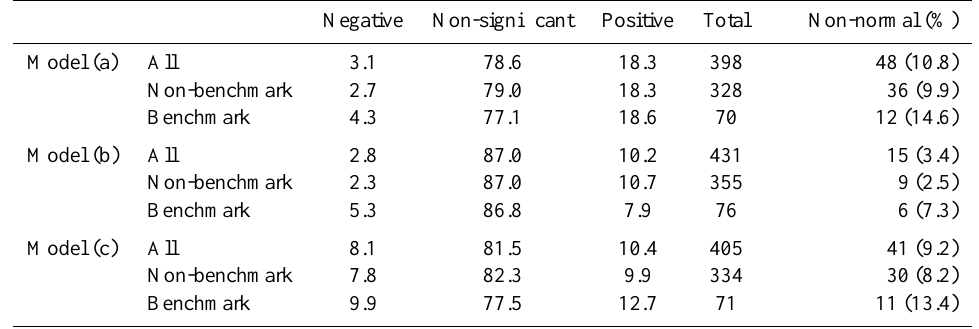
Table 1. Comparison of the proportions of significant and non-significant estimated slope coefficients in the whole data set, the non-natural series and near-natural series – annual maxima series.